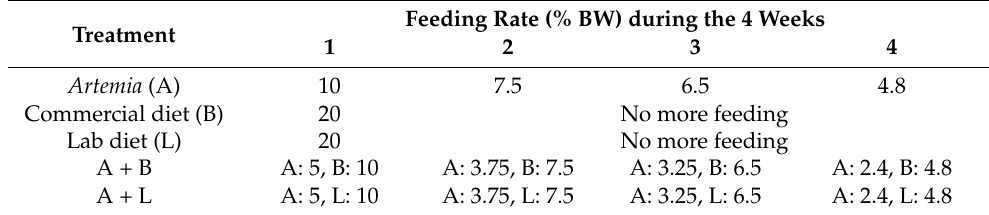
Table 1. Experimental treatments of Feeding trial I. Treatment